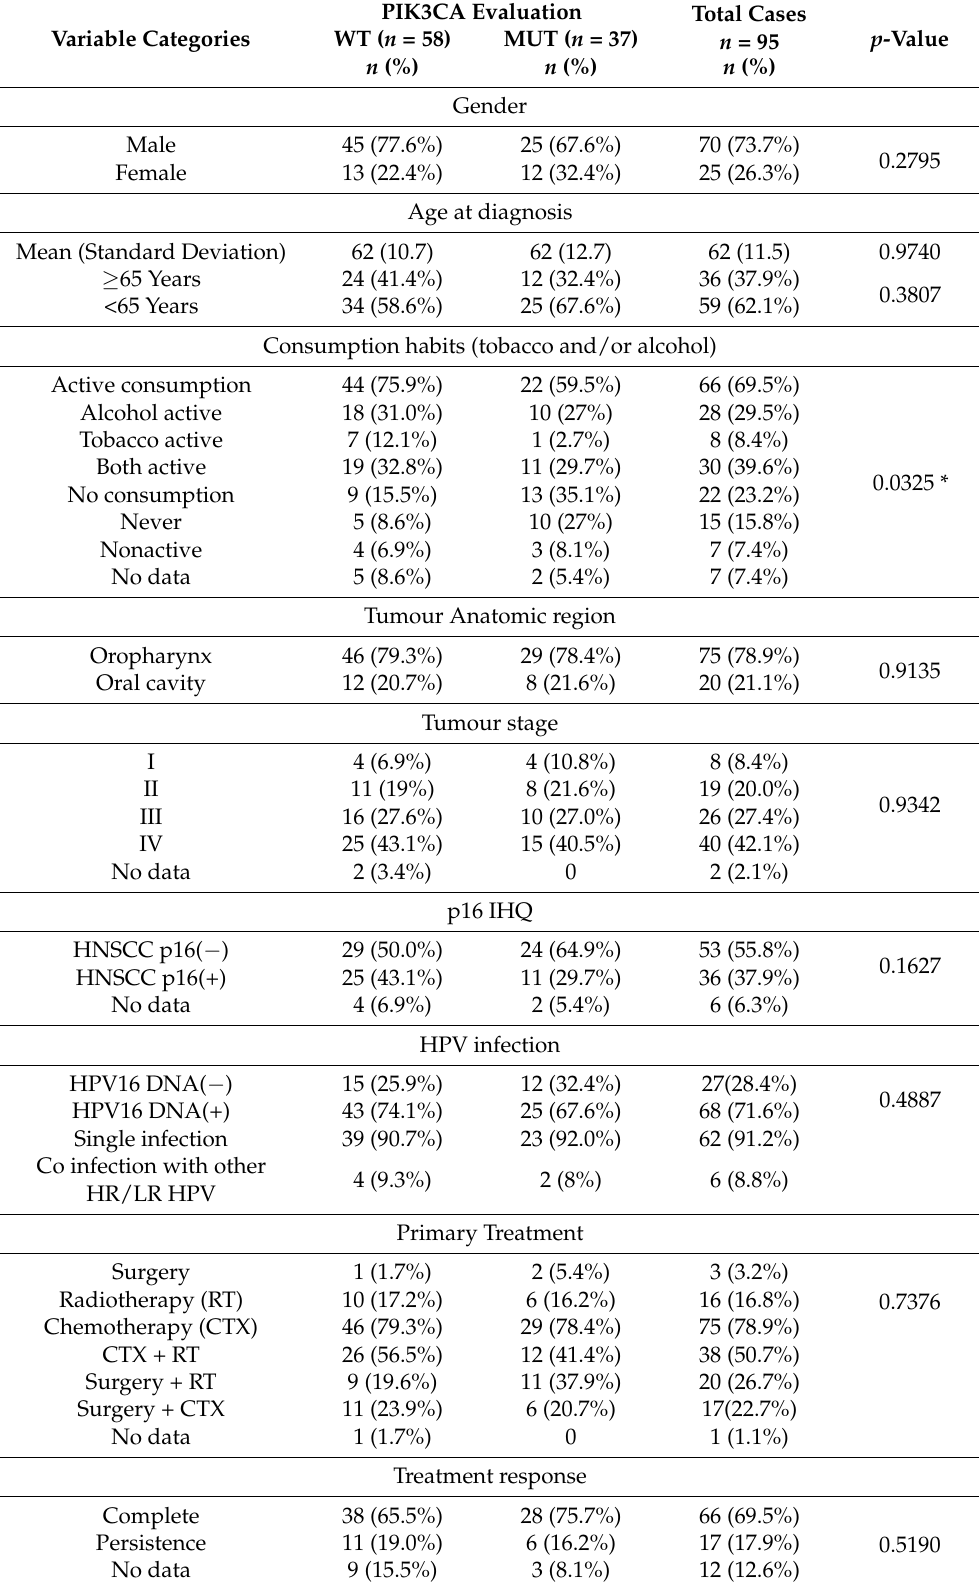
Table 1. Clinical, pathological, and demographic characteristics and association with PIK3CA